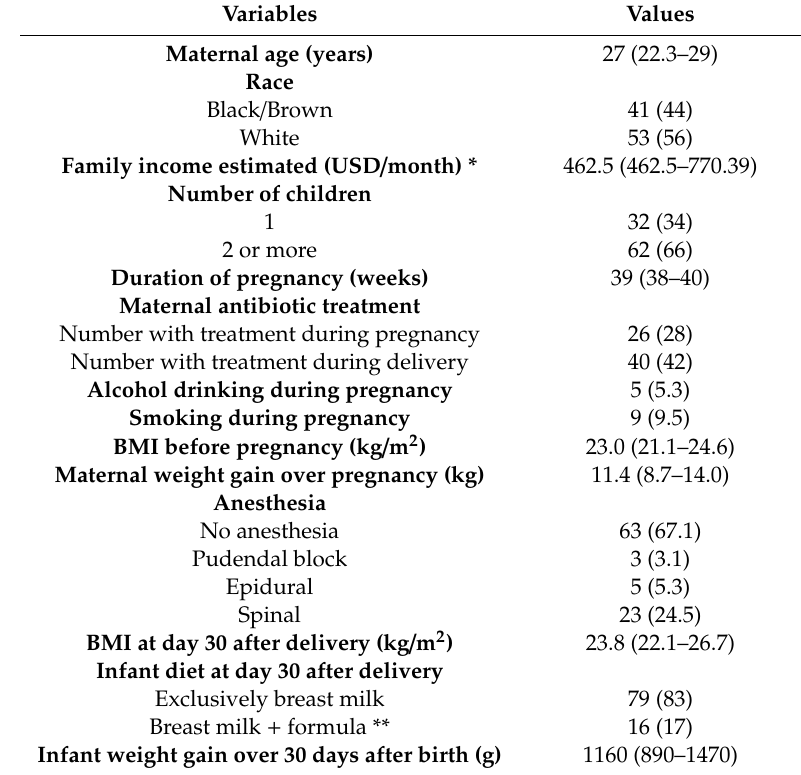
Table 2. Clinical and demographic characteristics of the volunteers included in the analysis ( n =